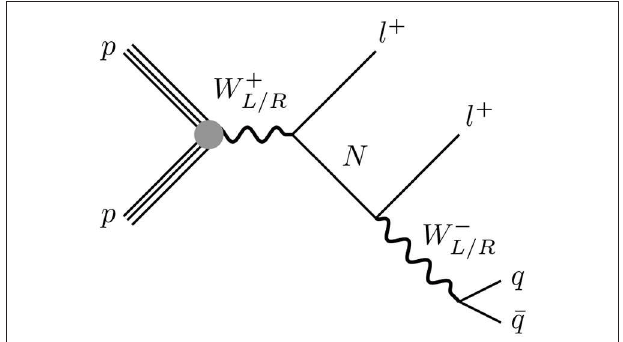
FIGURE 14 | Diagram for direct searches of neutrinos via W L / R